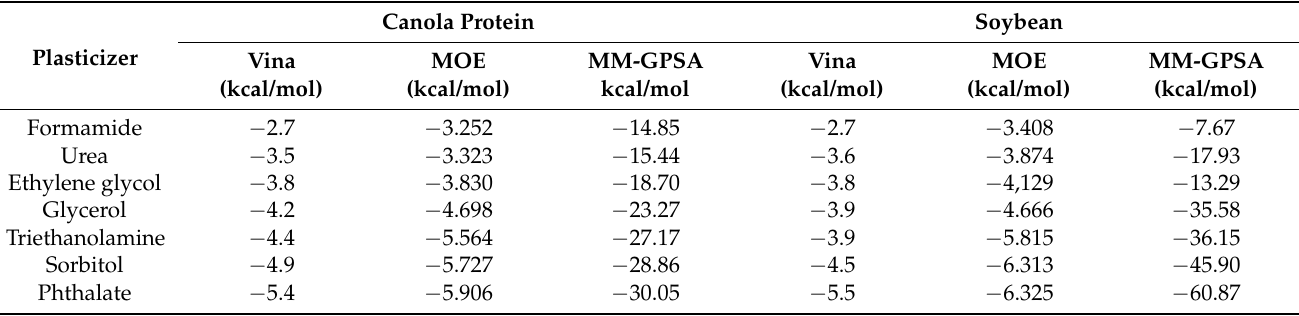
Table 2. Binding energies of protein–plasticizer